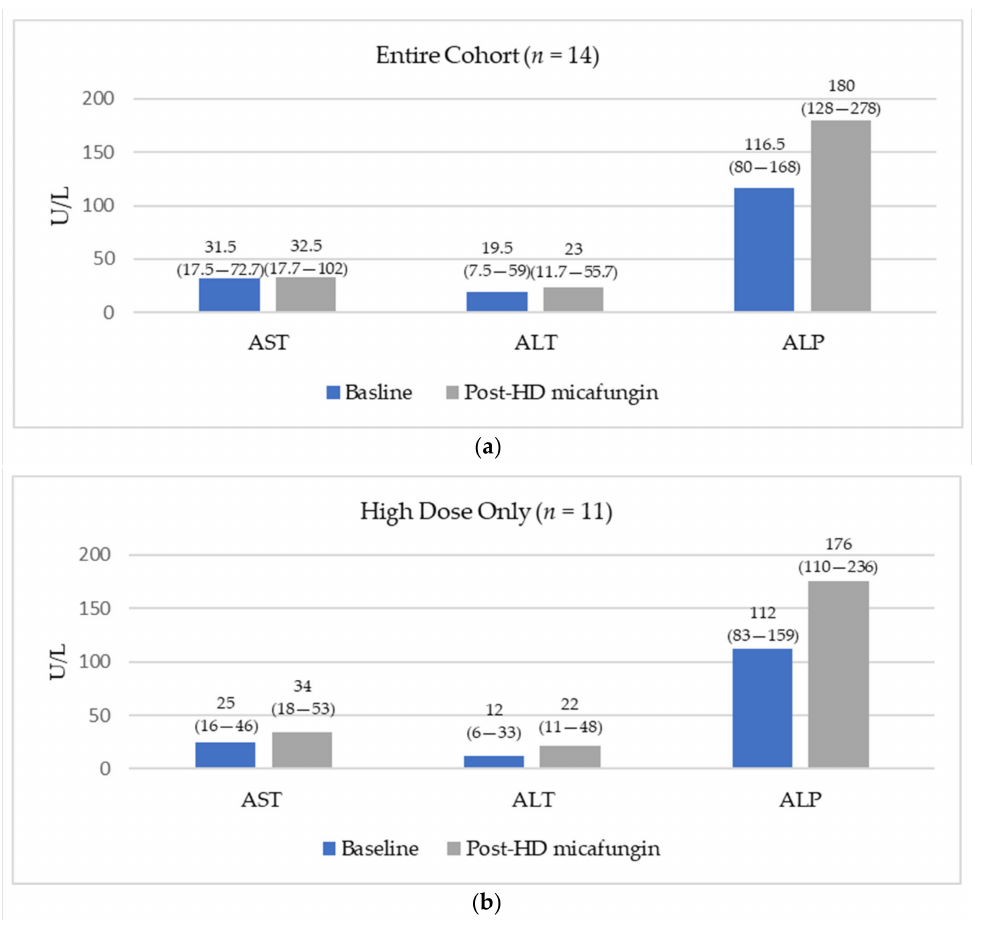
Figure 1. Median (interquartile range) baseline and post-HD micafungin AST, ALT, and ALP. Only includes patients with both baseline and post-HD micafungin laboratory data available. ( a ) Evaluates AST, ALT, and ALP trends among the entire cohort with available data; ( b ) evaluates AST, ALP, and ALP trends among patients that received HD micafungin for the entirety of their echinocandin course and had available